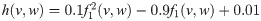
Results from reconstructing the state of a noise driven Fitzhugh-Nagumo system with small observation function error.Reconstruction results for the (a) intracellular potential v and (b) lump ionic recovery variable w are shown. The true observation function h(v,w)=0.1f12(v,w)-0.9f1(v,w)+0.01 is unknown to us, and in its place we use the observation model in Eq 10. Given the observations (blue circles), we attempt to reconstruct the true trajectories of v and w (solid black lines). In this example, the error between the filter observation function and true observation function is small enough that the standard filter (solid gray line) is able to provide accurate estimates of the variable trajectories (RMSE = 0.10, 0.07 for v and w respectively). The bias-corrected filter (solid red line) provides small, but not substantial improvements (RMSE = 0.10, 0.03 for v and w respectively).